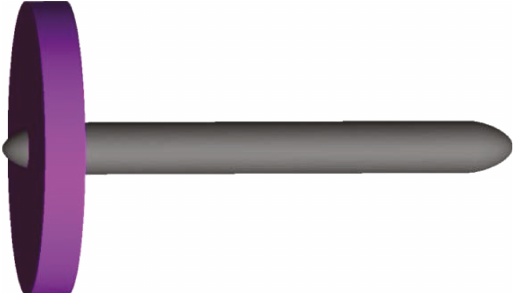
Figure 5: Sketch of a dynamic patched grid method of the